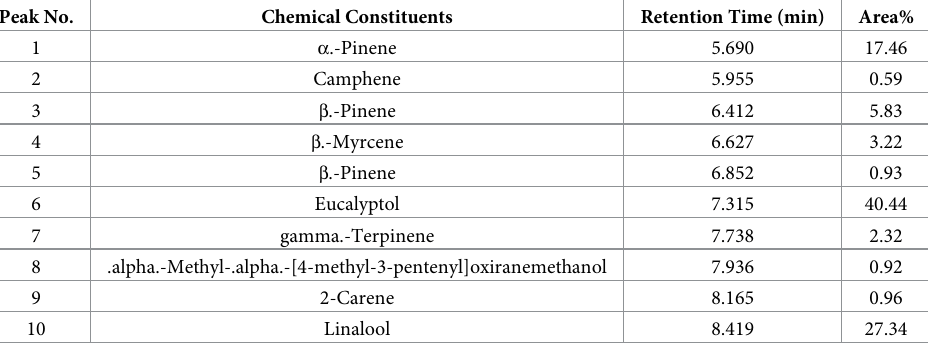
(Table 5). The results indicated that EO exhibited good repellent potential against both larvae Table 1. Chemical Constituents and composition (%) of essential oil from Callistemon citrinus . Peak